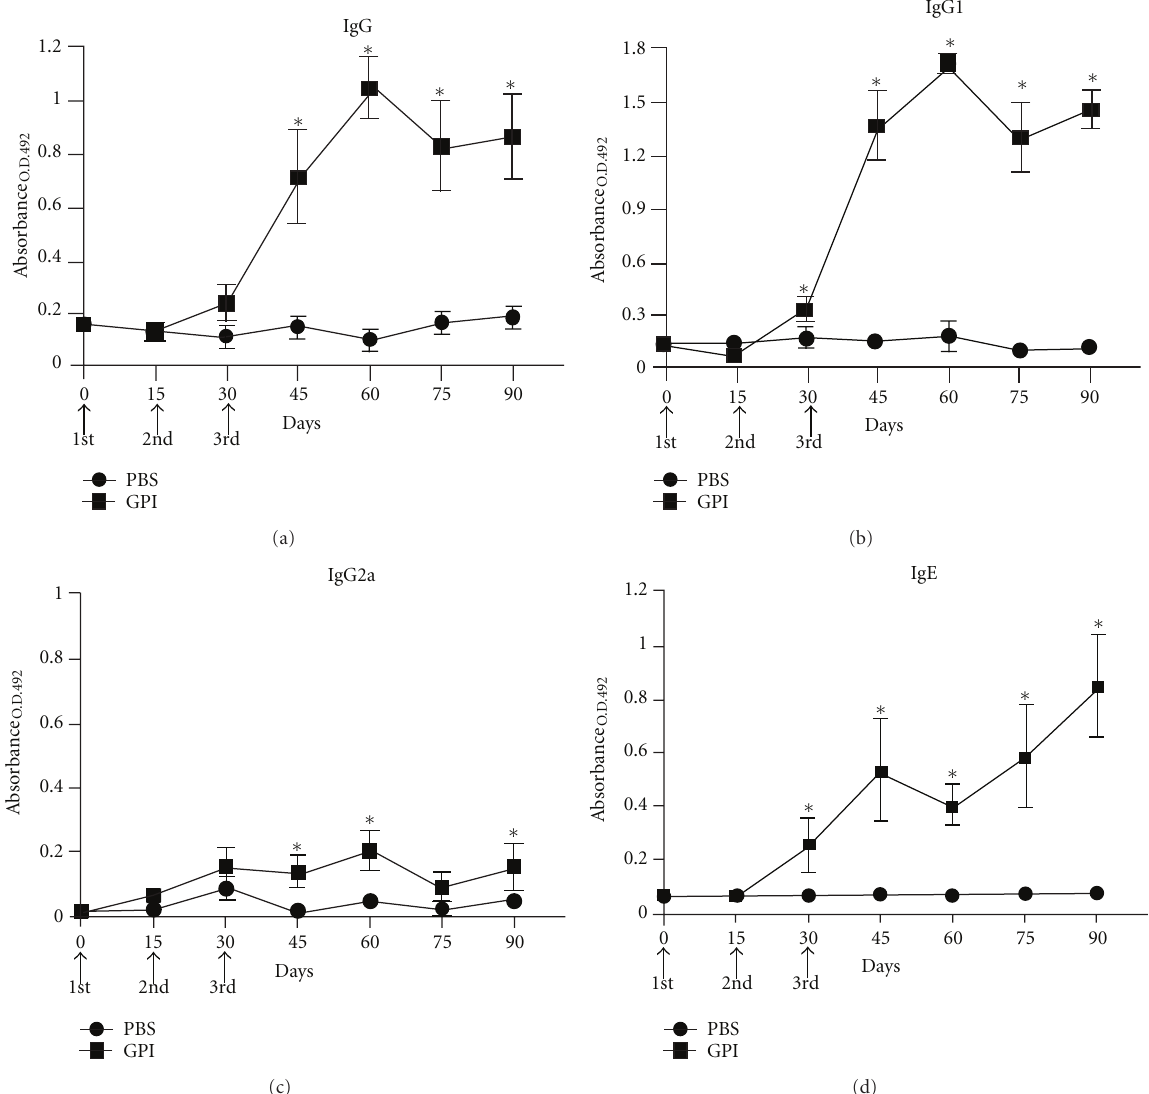
Figure 3: Kinetics of specific antibodies anti-Sm200/Sm29 in sera of mice vaccinated with GPI-Proteins preparations. Sera of 10 immunized mice per group were collected prior first immunization and at days 15, 30, 45, 60, 75 and 90 after first immunization and assayed by ELISA for IgG (a), IgG1 (b), IgG2a (c), and IgE antibodies (d). Control group was injected with PBS plus Freund adjuvant. Arrows indicate times of three immunizations. Results are presented as the mean absorbance measured for each group per day of sera collection. Asterisks indicate statistically significant di ff erences of vaccinated groups compared to control group ( P < 0 . 05). Results are representative of two independent biological